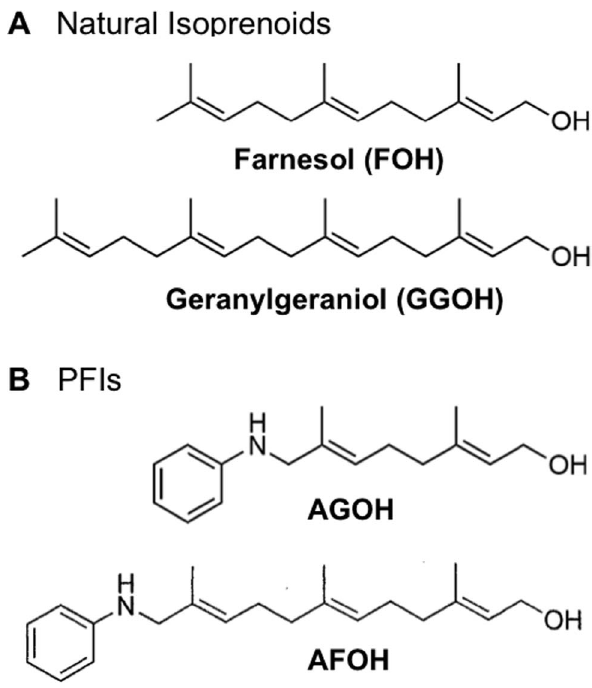
Figure 1. Prenyl Function Inhibitors. Structure relationship between natural isoprenoids (A) and lead PFIs (B).